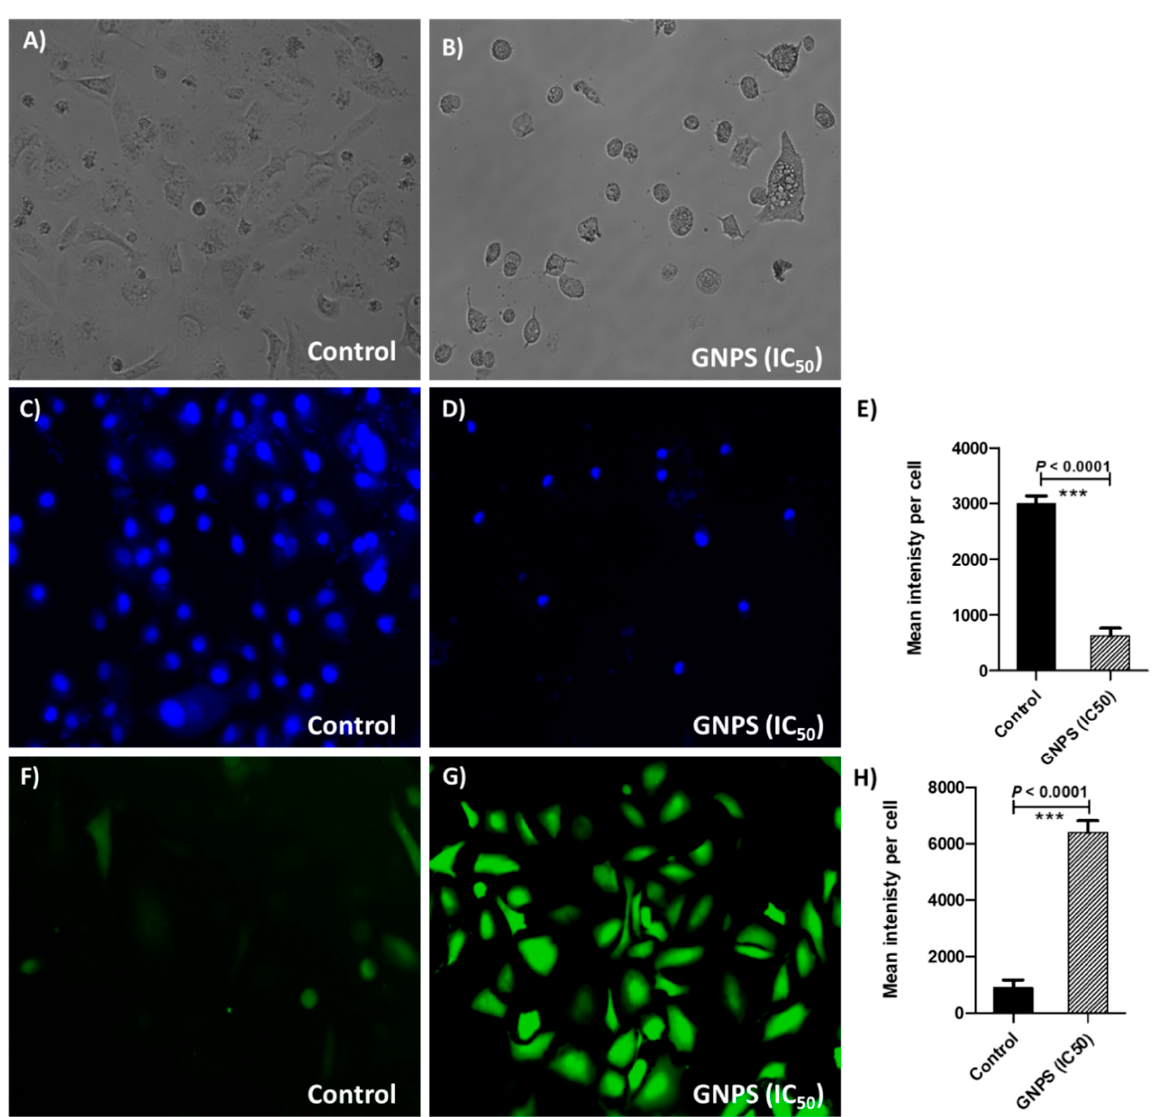
Figure 5. Evaluation of anticancer activity of GNPs. ( A , B ) Changes in cellular morphology: HeLa cells were pretreated with PBS (negative control) or GNPs in IC 50 for 48 h at 37 °C in 5% CO 2 atmosphere and the morphological changes were observed. ( C , D ) Changes in nuclear morphology: the nuclei of untreated control or treated HeLa cell with GNPs at IC 50 were stained with fluorescent nuclear dye DAPI. ( E ) The mean signal intensities and standard deviations for at least 50 DAPI stained treated or untreated HeLa cells with GNPs at IC 50 were measured. ( F , G ) Intracellular reactive oxygen species (ROS) production: untreated (control) or treated HeLa cells with GNPs at IC 50 were stained with fluorogenic reagent H2DCFDA. ( H ) The intensities of fluorescence in GNPs (IC 50 ) treated HeLa cells in comparison to untreated cells were measured; the mean signal intensities and standard deviations for at least 50 treated cells were calculated.